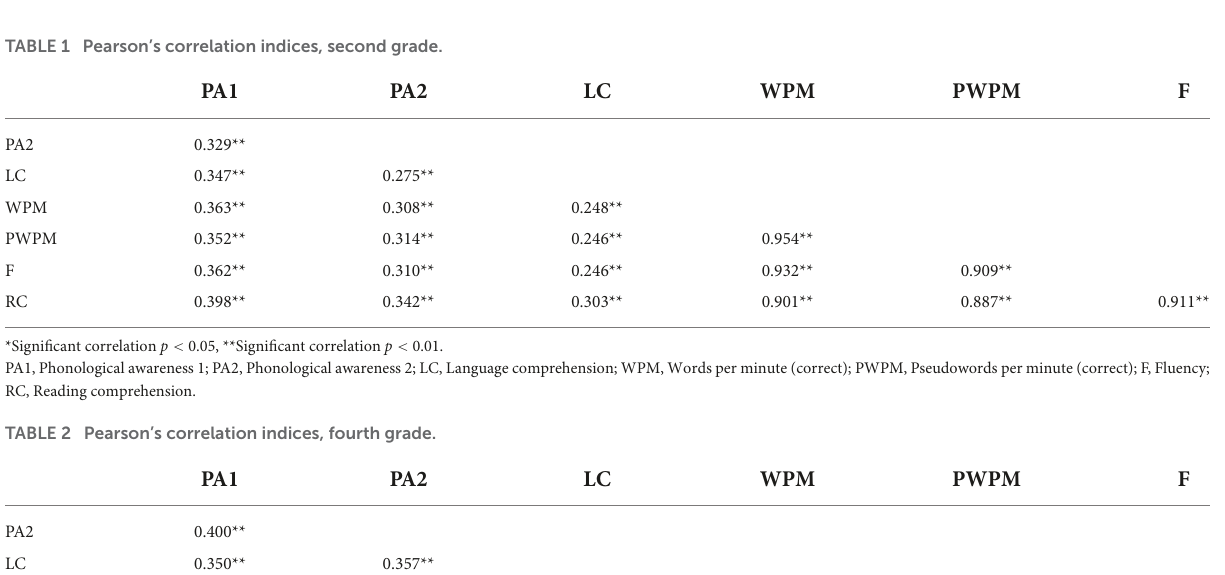
Figure 2 for a graphical representation of the analysis.